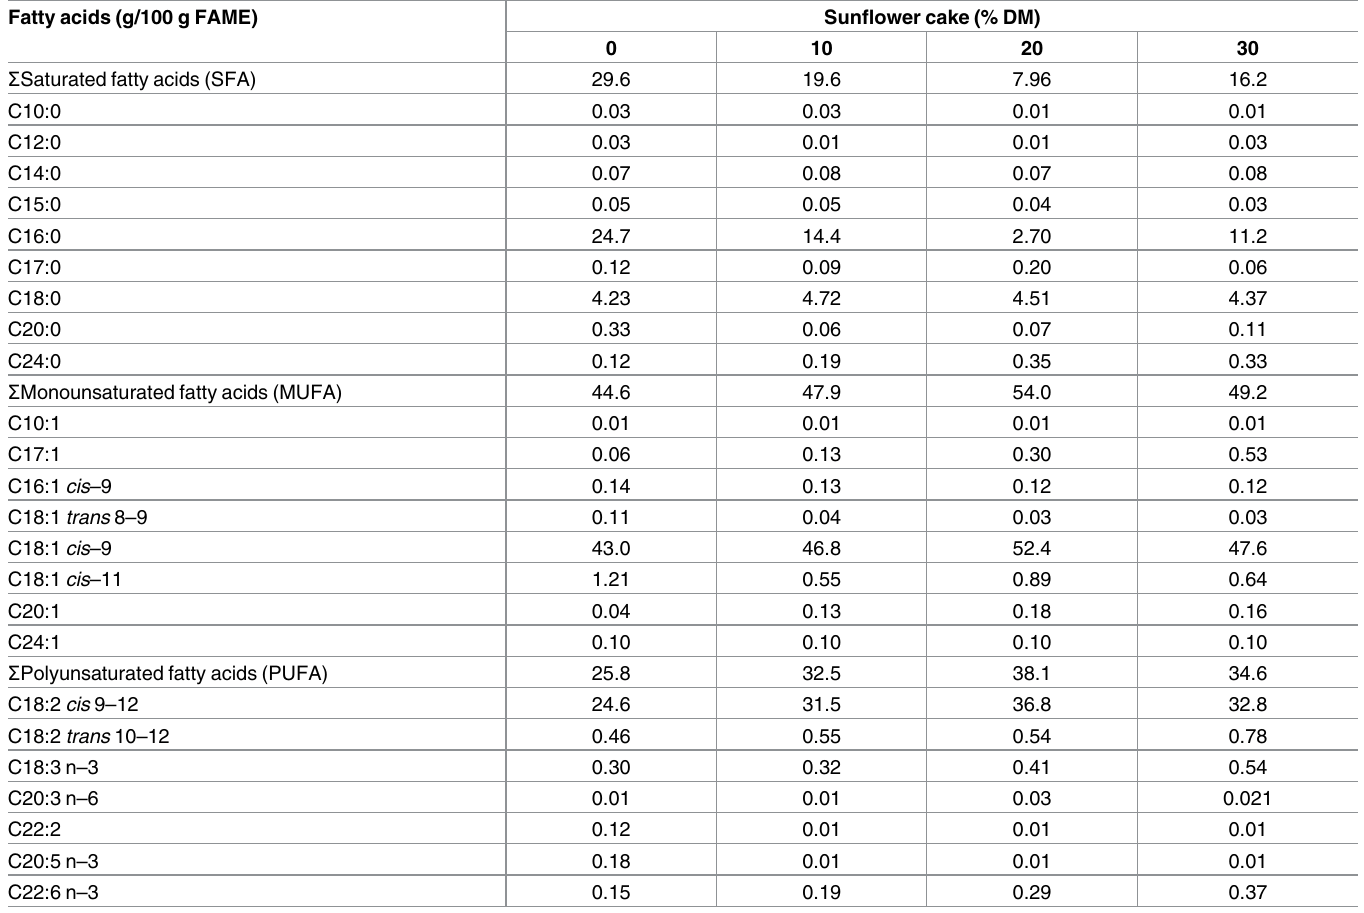
Table 2. Dietary fatty acid (g/100 g FAME) composition of experimental sunflower cake. Fatty acids (g/100 g